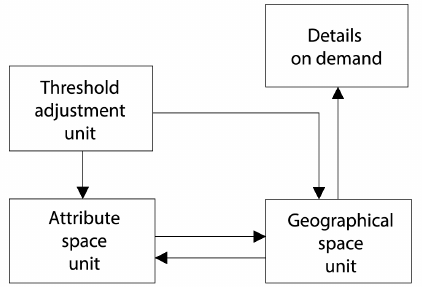
Figure 2. The interaction path between different units of the